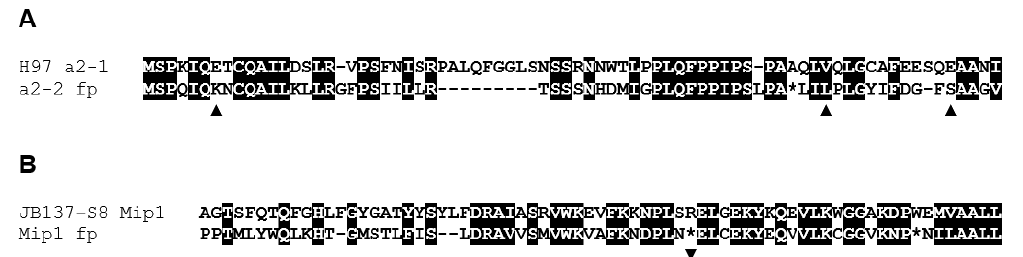
Figure 4. Comparison of ( A ) the first 74 aa of HD2 protein a2-1 of A. bisporus var. bisporus H97 with a translated sequence from a footprint (fp) of gene a2-2 in A. bisporus var. burnettii JB137-S8 (a2-2 fp) and ( B ) of 71 aa from the C- terminus of Mip1 of strain JB137-S8 and the translated sequence of a mip1 footprint (Mip1 fp) in the MAT locus of the strain (dashes in the sequences are introduced for optimization of the alignment; * mark positions of no aa due to stop codons, (cid:78) and (cid:72) , beneath the figure positions of frameshifts by insertion or deletion of a base,